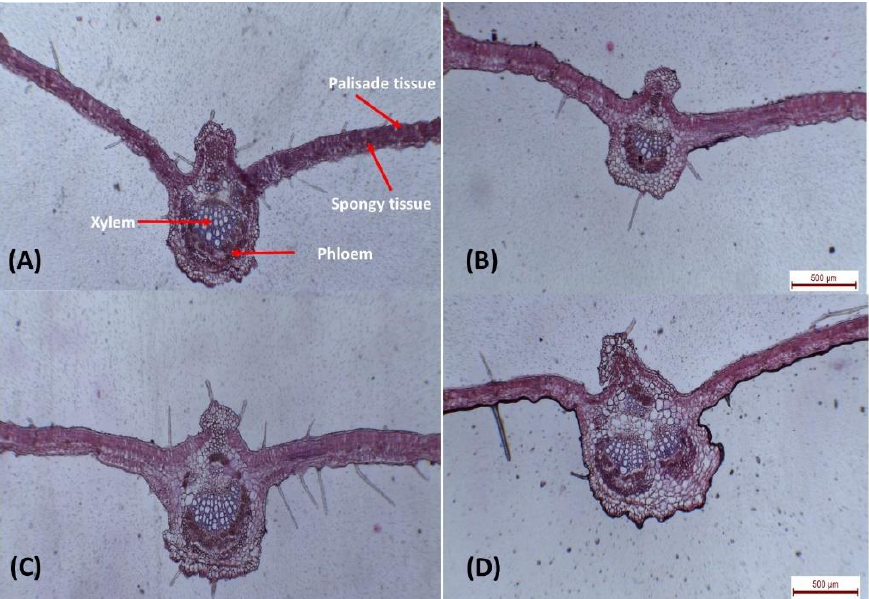
Figure 8. Transverse sections through the blade of soybean leaves at the age of 90 days, ( A ). Control plant (100% FC), ( B ). Negative control plant (50% FC), ( C ). Plants sprayed with Cu-NPs at 3 mM, and ( D ). Plant sprayed with GA NPs at 1 mM, 40×. Table 2. The effect of Cu-NPs (3 mM) and GAS-NPs (1 mM) on anatomical characters of soybean leaf (µm) under drought stress (50% FC).